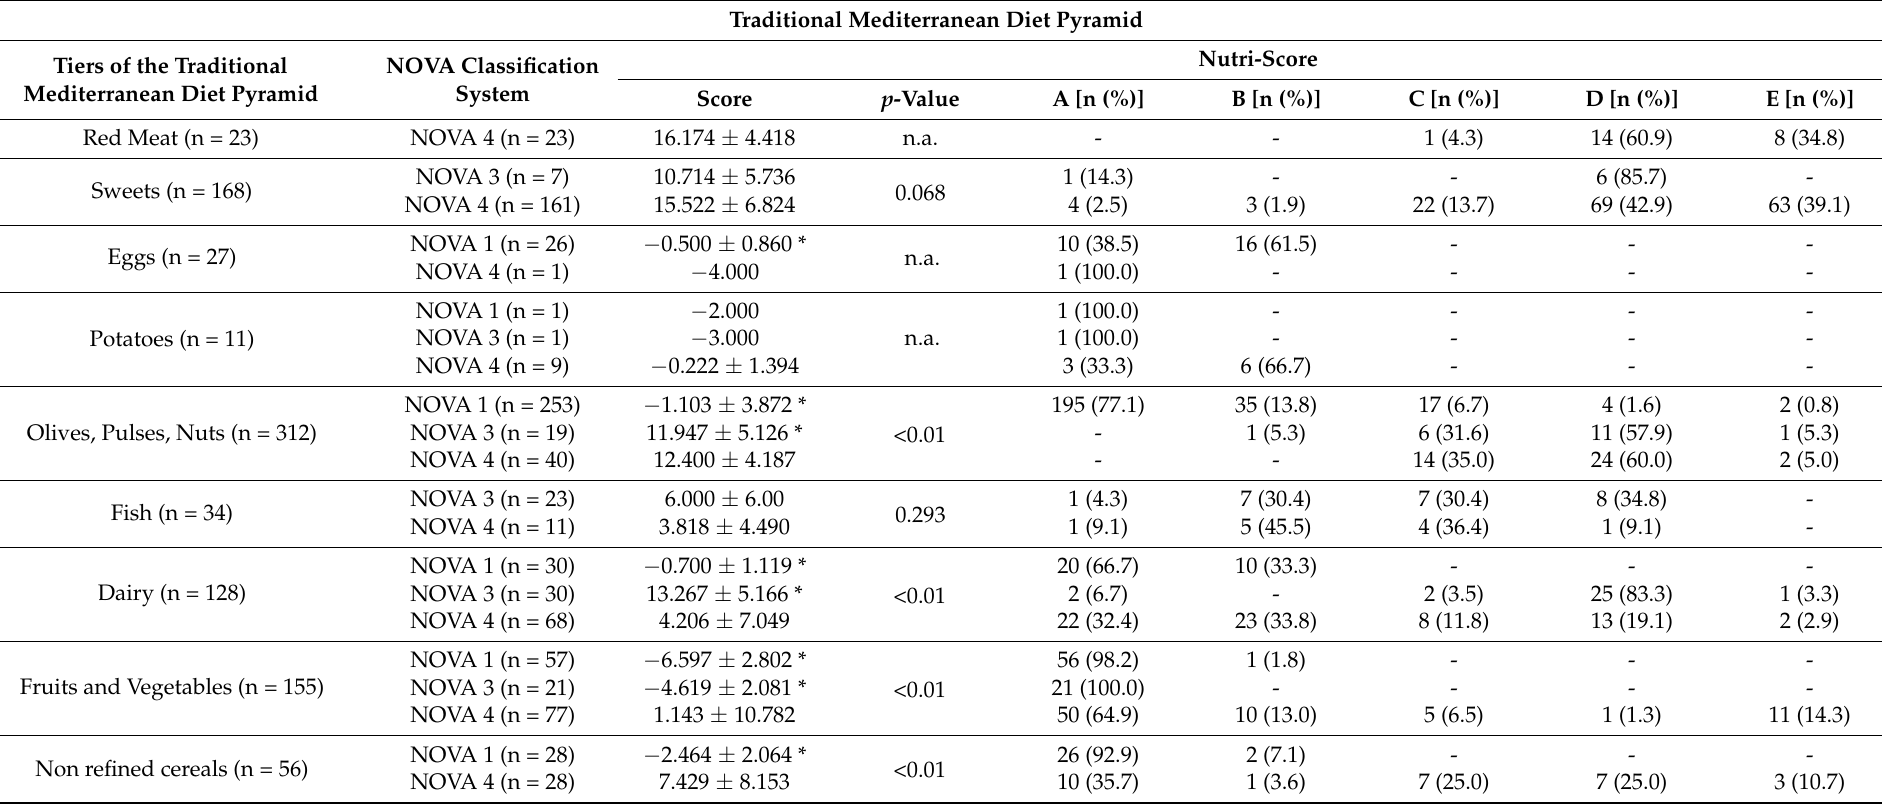
Table 6. The NOVA classification system, FSAm-NPS score, and distribution of the Nutri-Score grades across the traditional MD pyramid’s